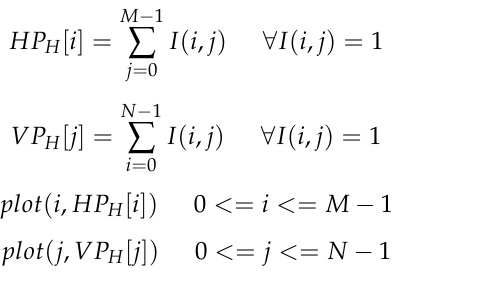
Here, M represents the rows and N represents the columns of the image. I ( i , j ) represents the intensity value of the image and it is is 1 it indicates ON pixel. The histogram horizontal projection is the plot between rows of the image and count of ON pixels in each row as shown in Equation